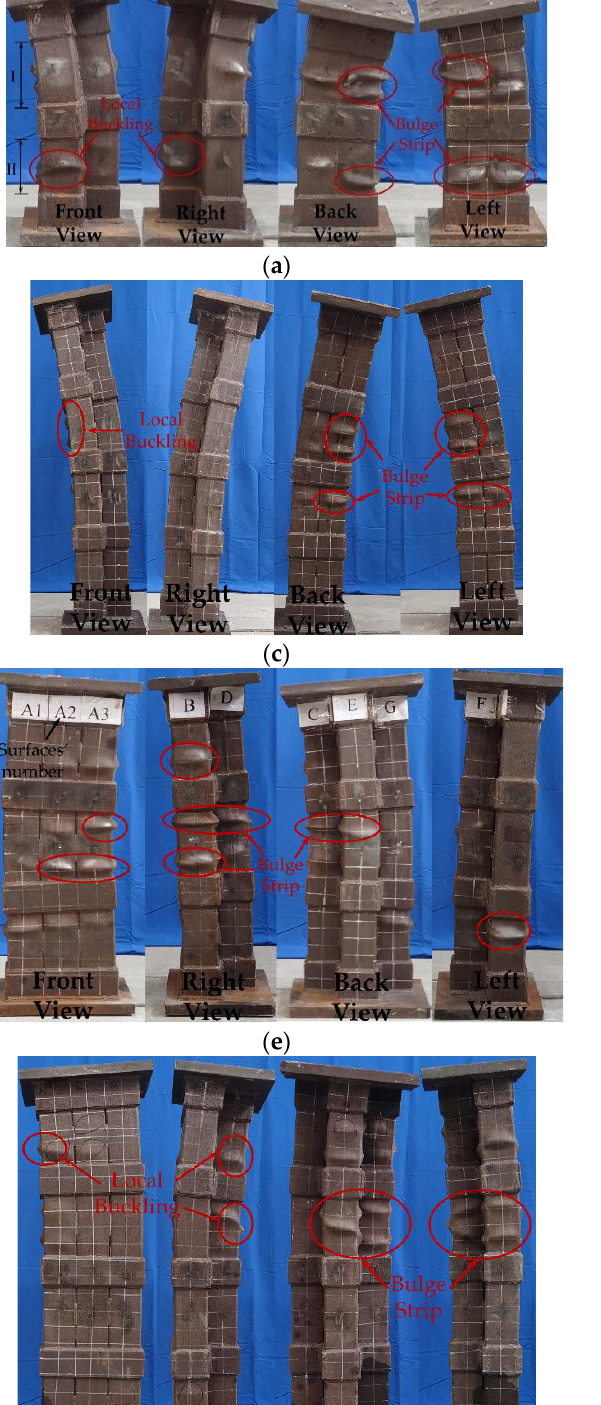
1, HL-2, HT-1, and HT -2) and weld-type stub specimens (WL-1 and WT-1) showed local